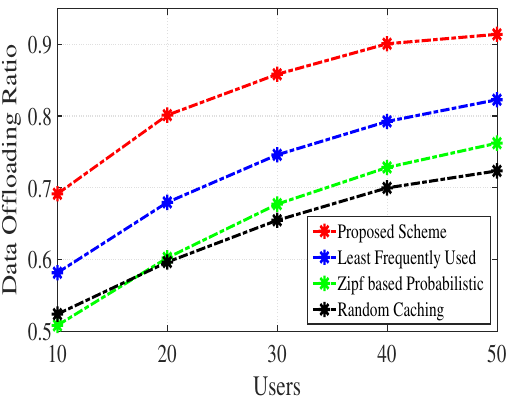
Figure 2. Data offloading ratio versus users with F = 100, H = 50 MB, and Q = 0.4